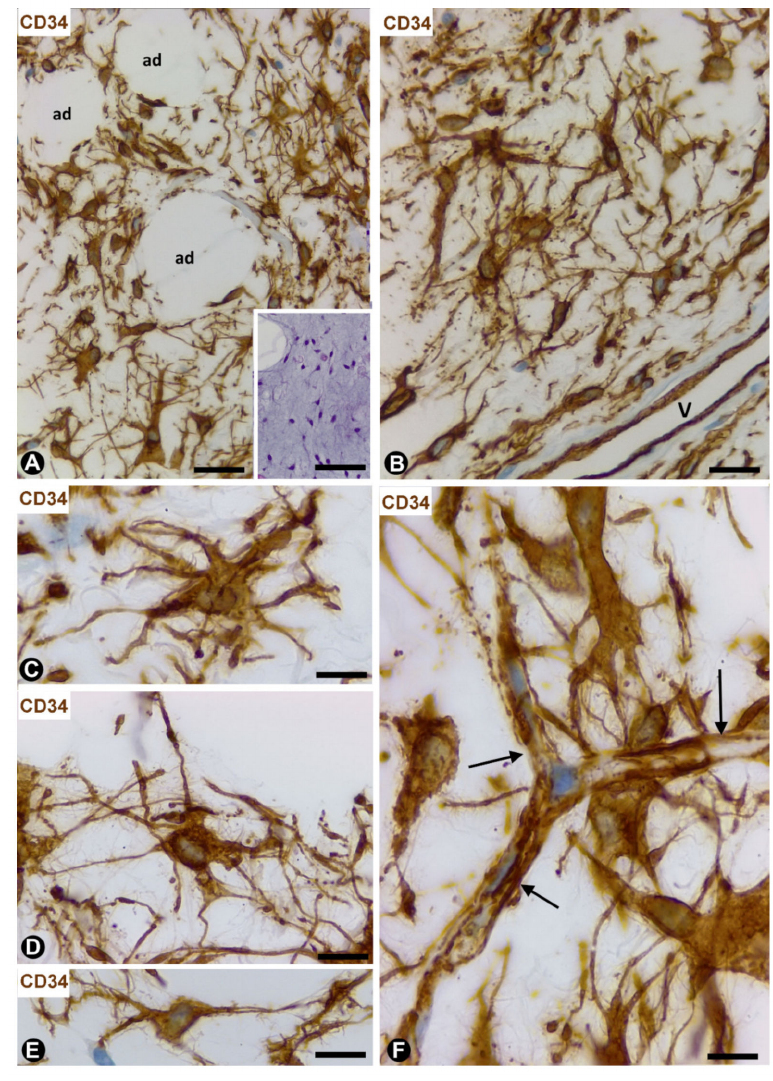
Figure 7. Dendritic fibromyxolipoma. ( A – F ): CD34 immunochemistry with haematoxylin counterstain. CD34 + dendritic cells (brown) between adipocytes (ad) ( A ) and near a vessel (v, ( B )). Observe the stellate aspect ( C , D ) and contacts with neighbouring cells ( E ) and small vessels (( F ), arrows). Insert of A: image in a section stained with haematoxylin and eosin, bar: ( A , B ): 60 µ m; (insert of ( A )): 100 µ m; ( C – E ): 20 µ m; ( F ): 30 µ